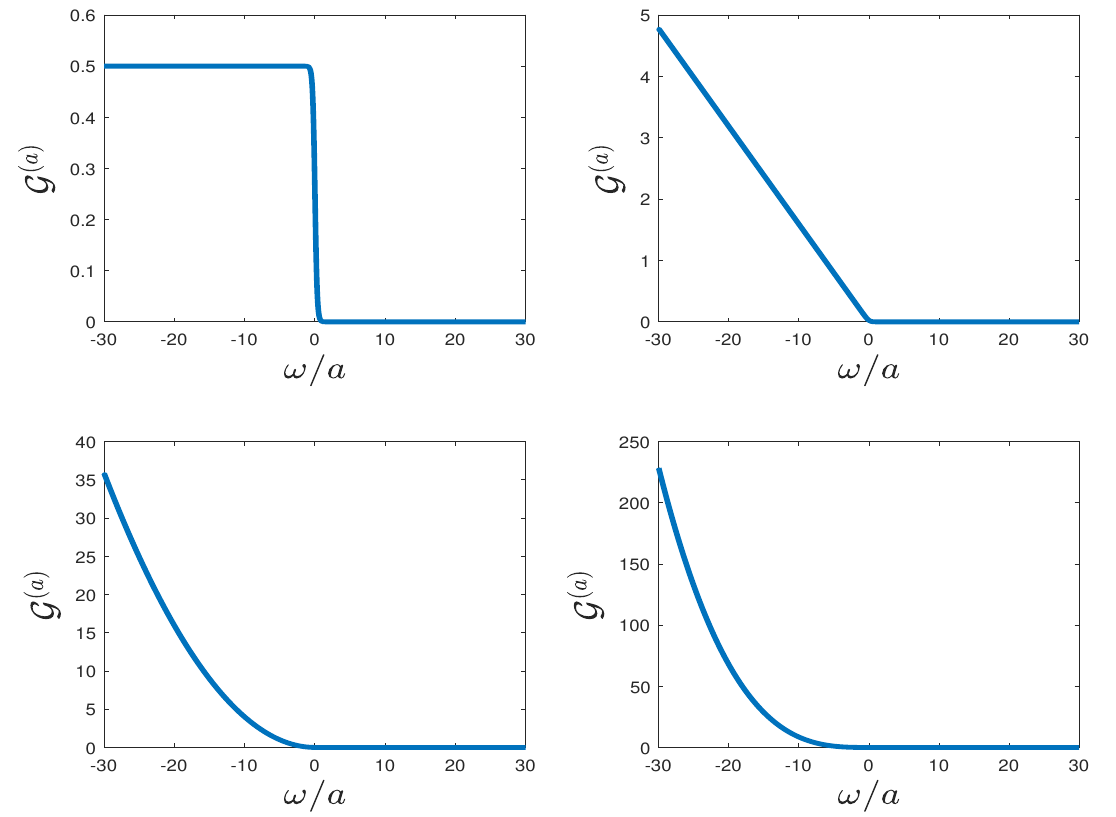
Figure 1 . Behavior of G ( a ) in different spacetime dimensions. The four subfigures stand for D = 3 , D = 4 , D = 5 , D = 6 respectively from left to right and top to